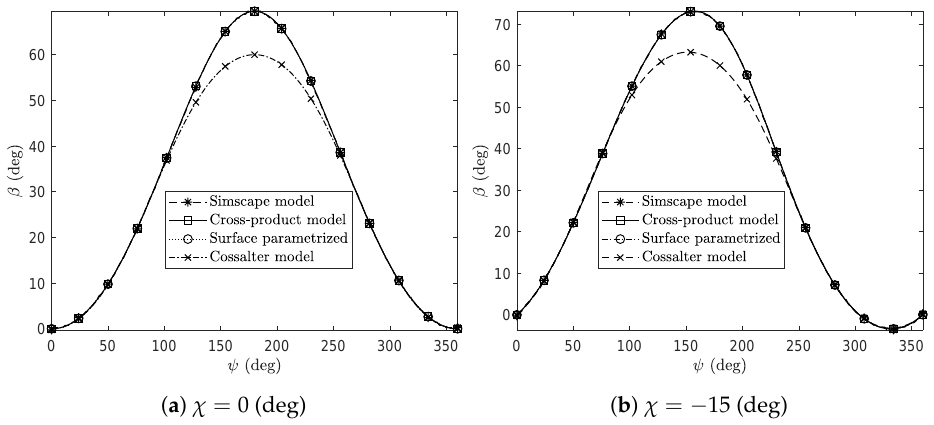
Figure 12. Variation of the front wheel contact point migration angle for a complete rotation of the vehicle handlebars. ( a ) presents the variation of the angular position of the contact point in the local reference frame of the front wheel denoted with O 3 X 3 Y 3 Z 3 for a constant roll angle of the rear frame equal to zero. ( b ) presents the variation of the angular position of the contact point in the local reference frame of the front wheel denoted with O 3 X 3 Y 3 Z 3 for a constant roll angle of the rear frame equal to χ = − 15